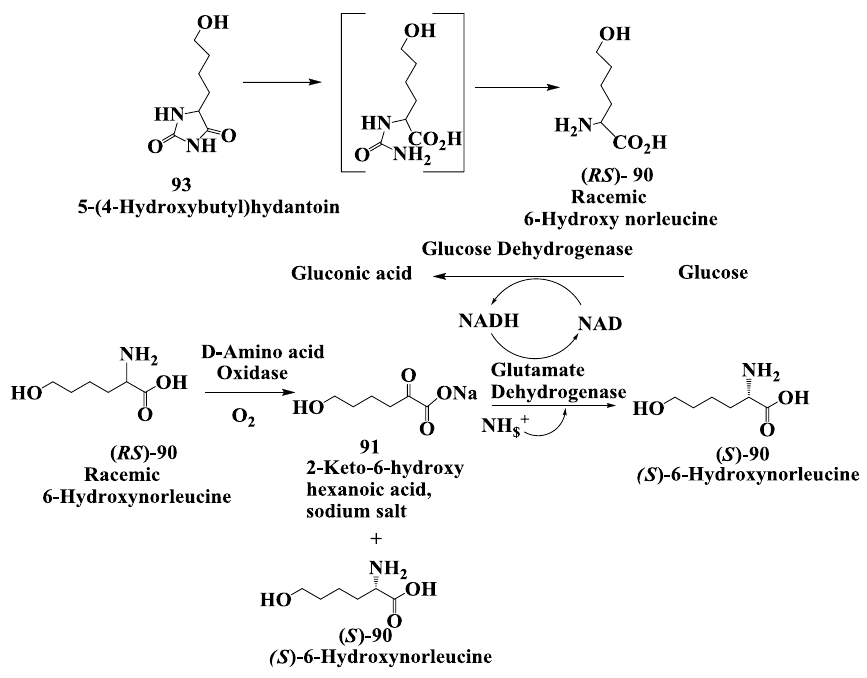
Figure 24. Vanlev: Enzymatic conversion of racemic 6-hydroxy norleucine to ( S )-6-hydroxymorleucine.